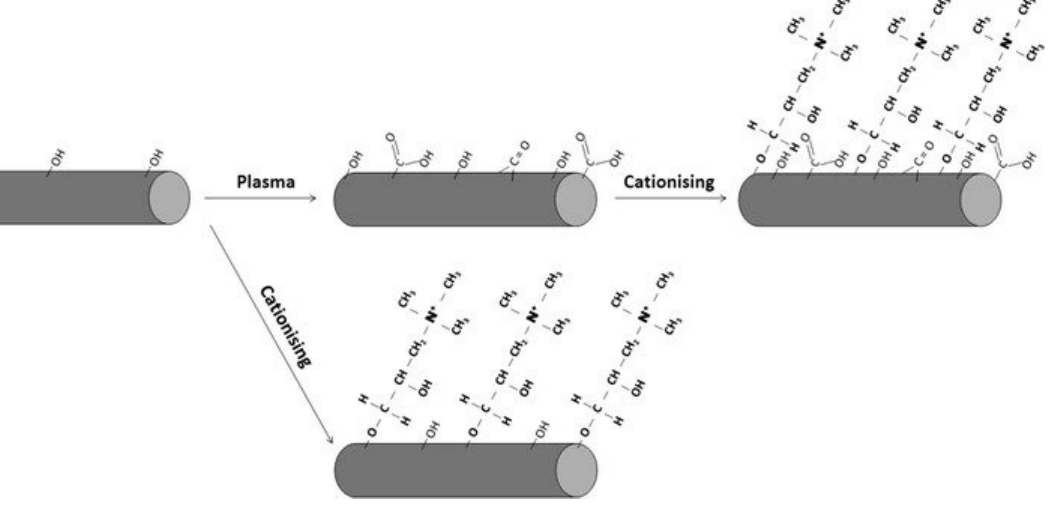
Figure 3. The effects of plasma and cationising processes. Reprinted with permission from Ref.